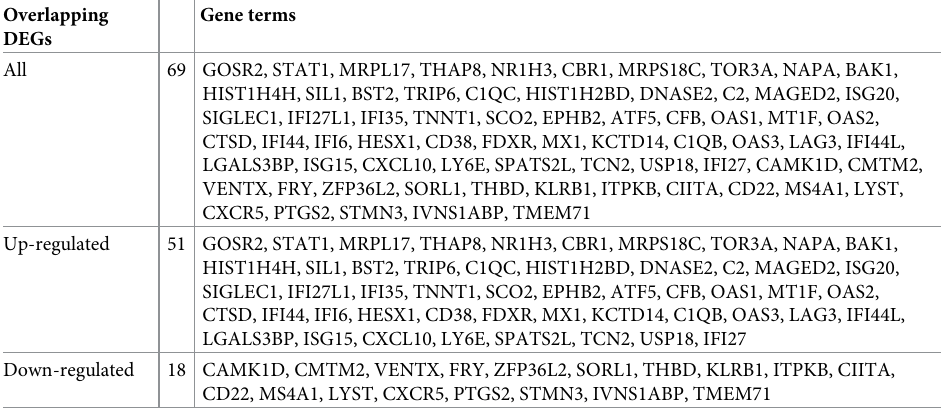
Table 2. Up-regulated genes and down-regulated genes of overlapping DEGs. Overlapping Gene DEGs